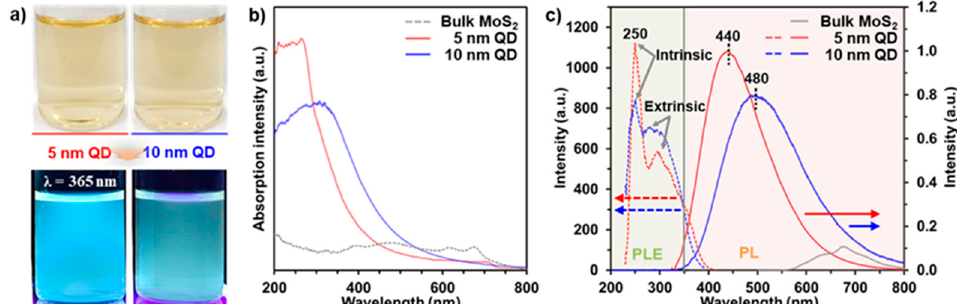
Figure 2. Characterizations for the 5 ‐ and 10 ‐ nanometer MoS 2 QDs. ( a ) Digital images of the MoS 2 QDs before and after emission under excitation of λ = 365 nm. ( b ) UV–Vis absorption spectra of the bulk MoS 2 flake, 5 ‐ and 10 ‐ nanometer MoS 2 QDs. ( c ) PLE and PL spectra of the MoS 2 QDs under exaction at 440 and 480 nm, respectively.